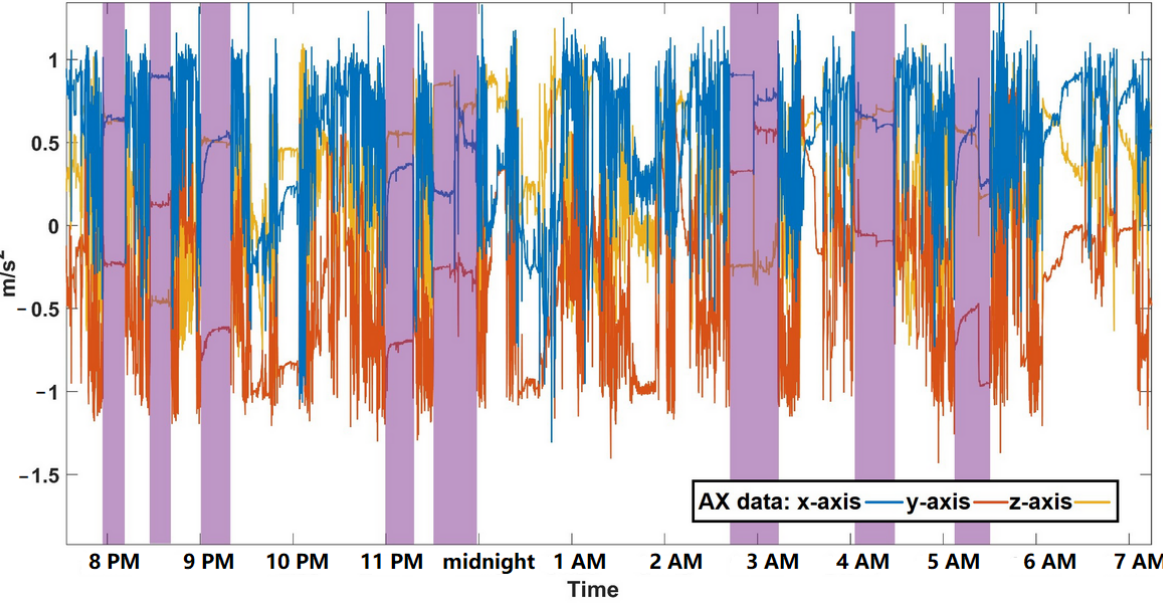
Figure 9. An 11-hour period (between 8 PM and 7 AM) of AX3 data for older adults living with dementia 2. Periods of relatively static data are shown by purple rectangles. WT: wrist